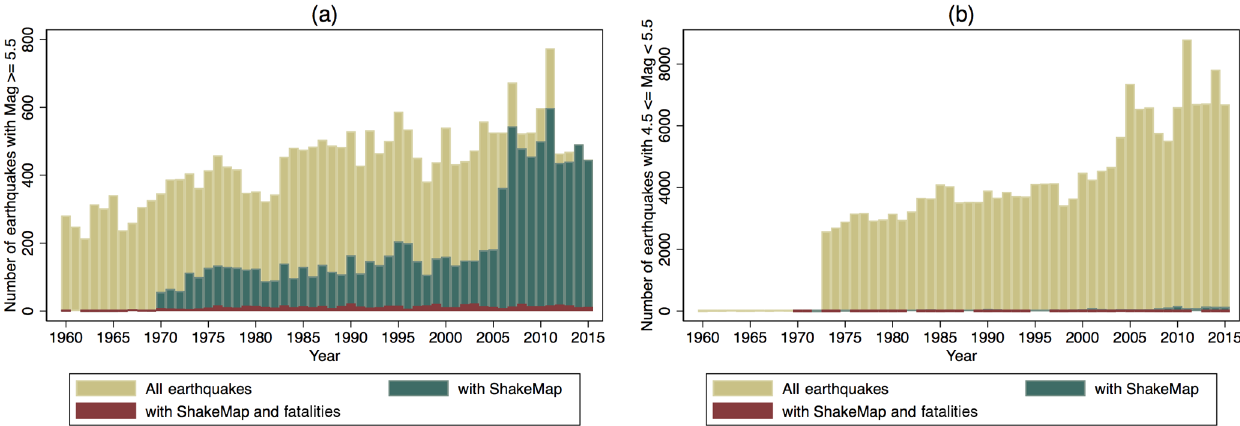
Figure C3. Number of earthquakes per year for given magnitude ranges. Before 1973 ComCat has a significant number of missing events, particularly for events with magnitude below 5.5. Between 1960 and 1970 ShakeMaps only exist for individual events with (high) fatalities. Starting 1973, ShakeMaps are produced systematically, and from 2007 onwards almost all events with magnitude 5.5 or greater have a ShakeMap.